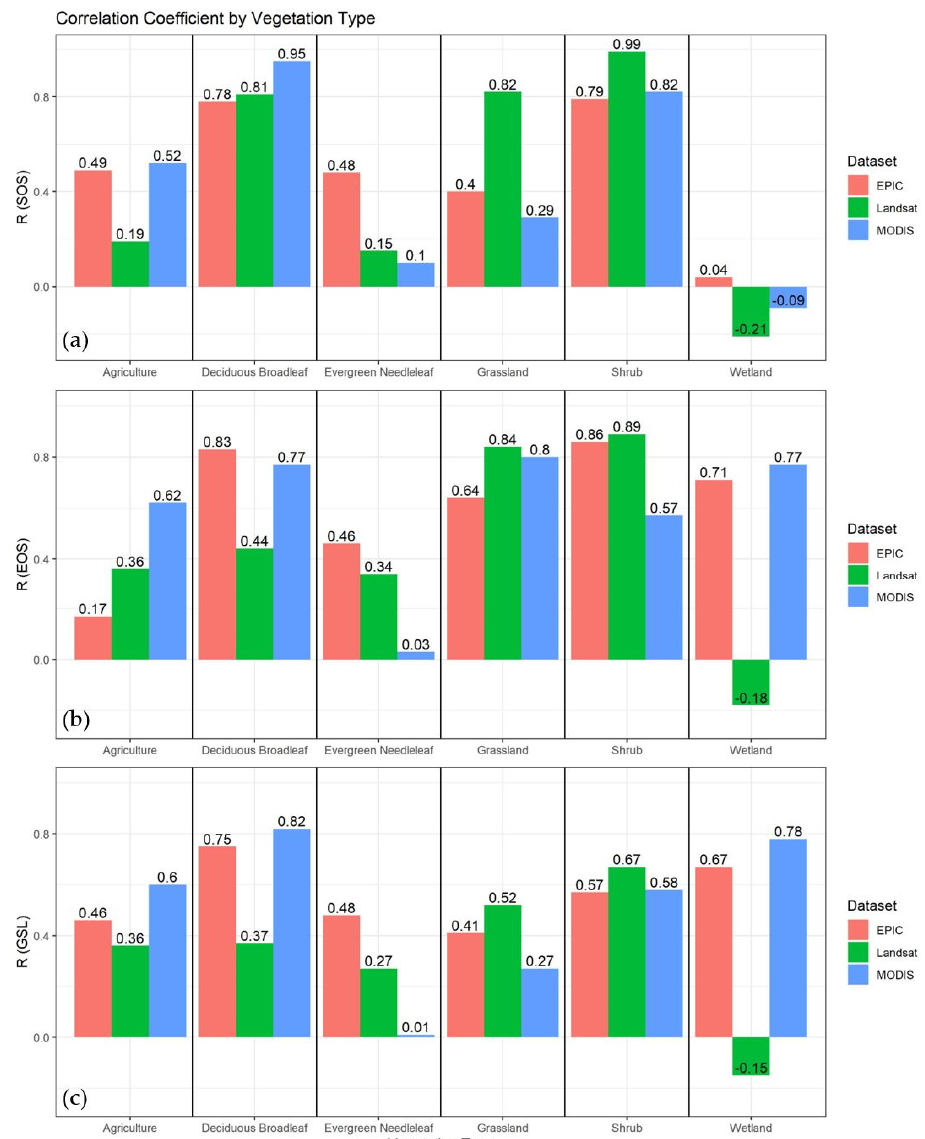
Figure 10. The correlation of three satellite-based datasets and PhenoCam for ( a ) SOS, ( b ) EOS, and ( c ) GSL phenology indicators, by vegetation type from 2016–2018.